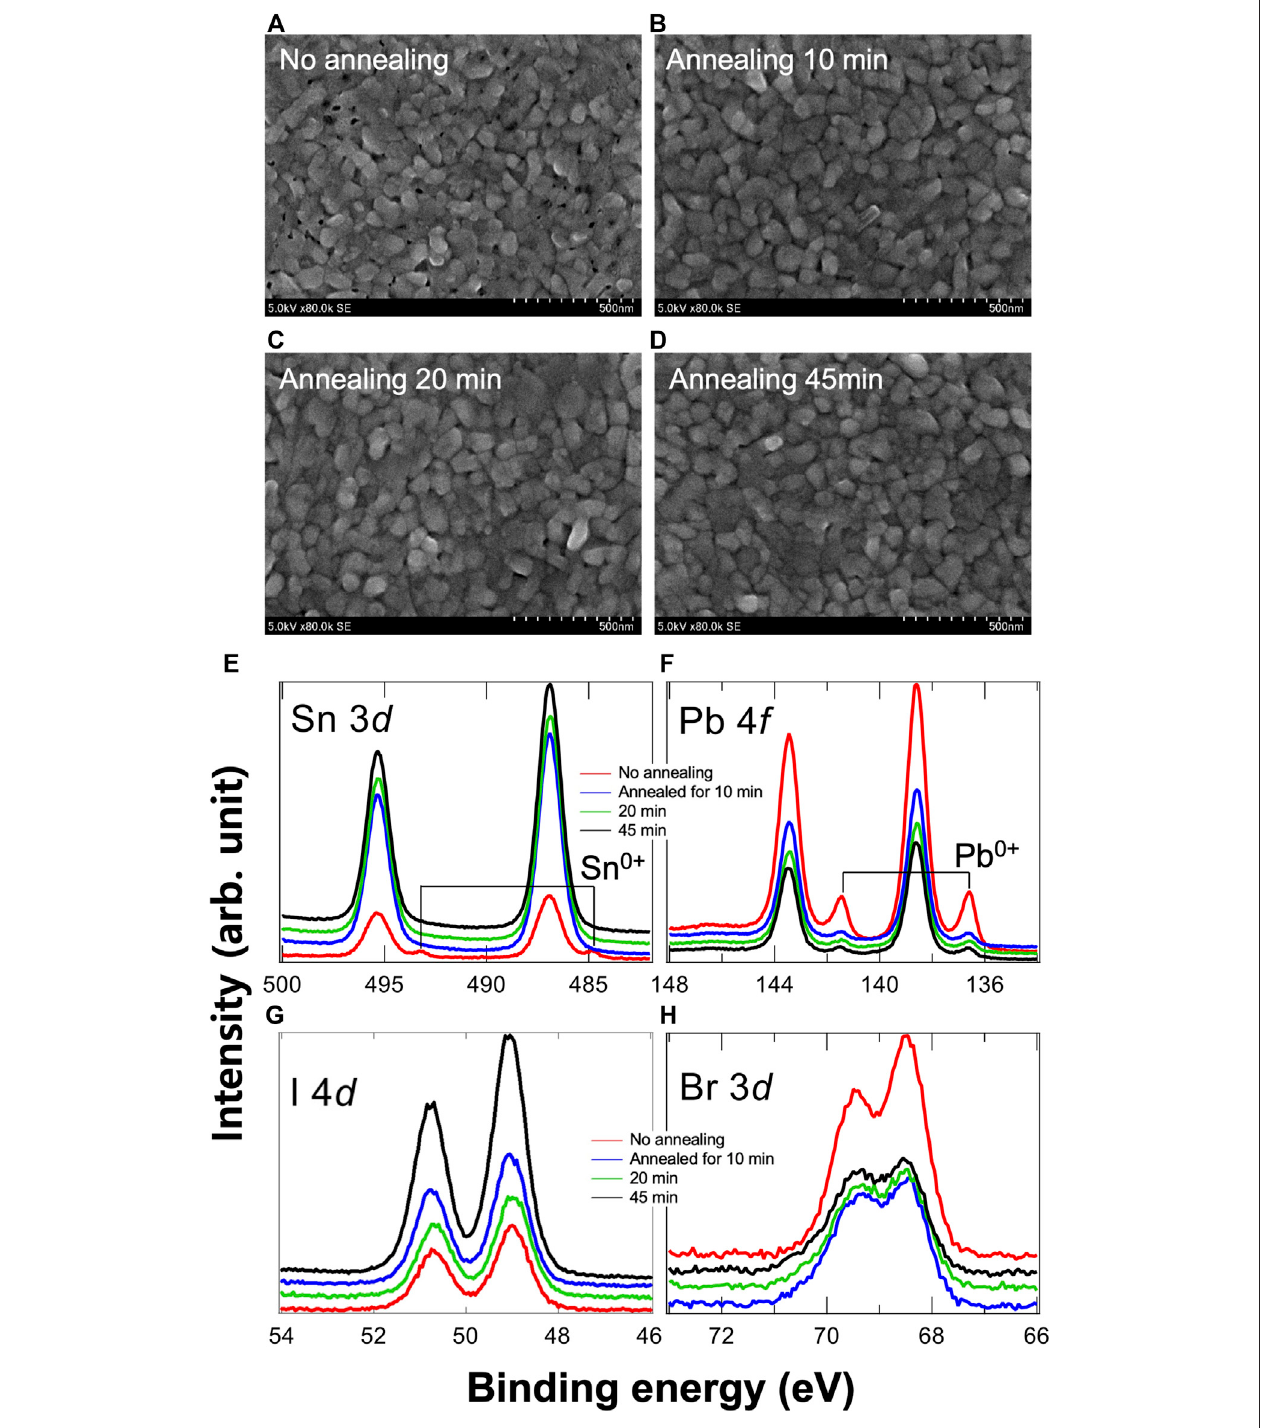
FIGURE 2 | Surface morphologies of PbBr 2 /SnI 2 after (A) no-annealing, (B) 10-min annealing, (C) 20-min annealing, and (D) 45-min annealing treatments. The grain sizes do not show any signi fi cant change. Additionally, the vacant area disappears after annealing. Chemical states of (E) Sb 3 d , (F) Pb 4 f , (G) I 4 d , and (H) Br 3 d core-levels. Because of the annealing process, we con fi rm that a physical mixture of PbBr 2 /SnI 2 is formed because there is no new chemical state, and changes in the peak intensities only are observed.